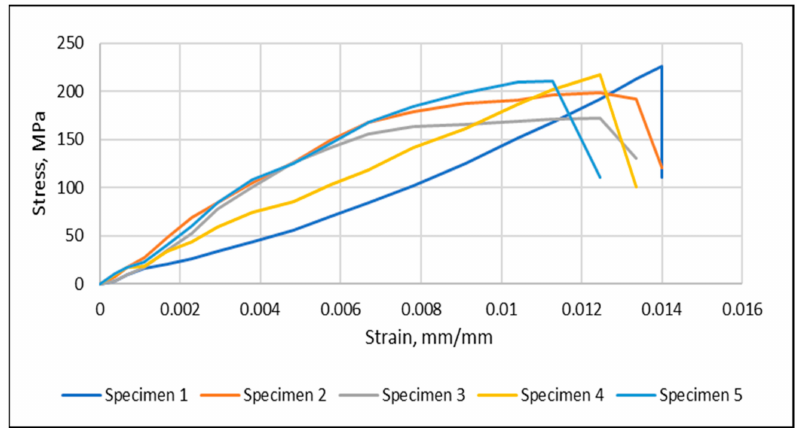
Figure 13. Tensile test result—0.5% volume fraction pure CA.